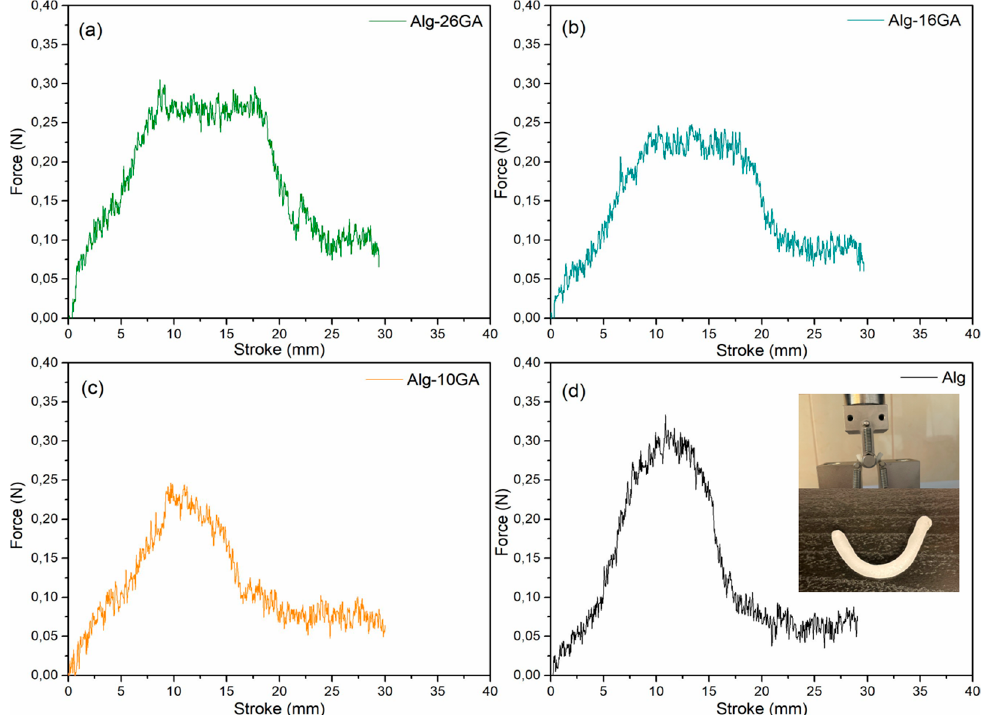
Figure 12. Force–displacement curve of Alg-xGA composites: x = 0 ( a ), x = 10 ( b ), x = 16 ( c ), and x = 26 ( d ); hydrated composites in three-point bending test con fi guration.